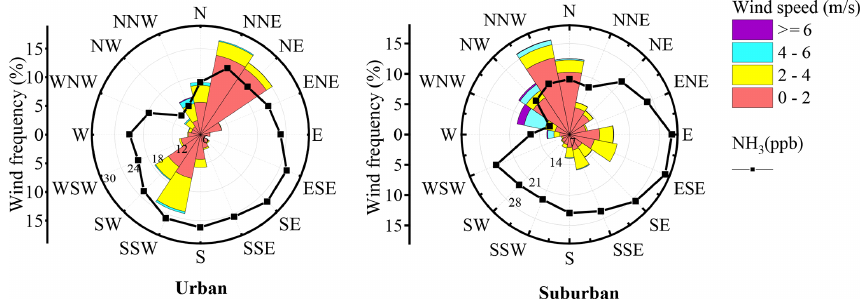
Figure 7. Wind rose diagrams of the NH 3 mixing ratios, wind frequency, and wind speed in different wind direction